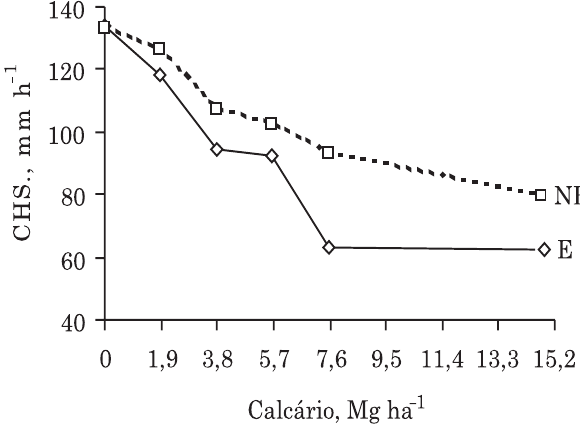
Figura 3. Condutividade hidráulica saturada (CHS) do solo esterilizado (E) e não esterilizado (NE), de acordo com as doses crescentes de